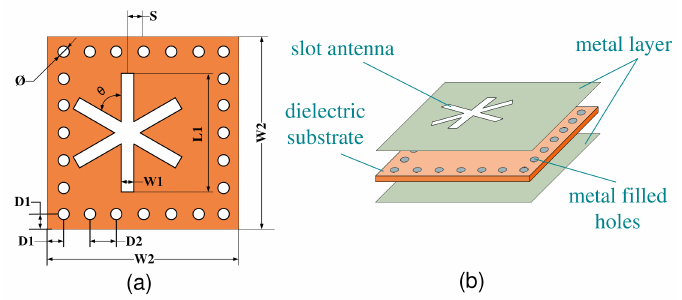
Figure 2. ( a ) Sensor plane structure, ( b ) sensor hierarchy